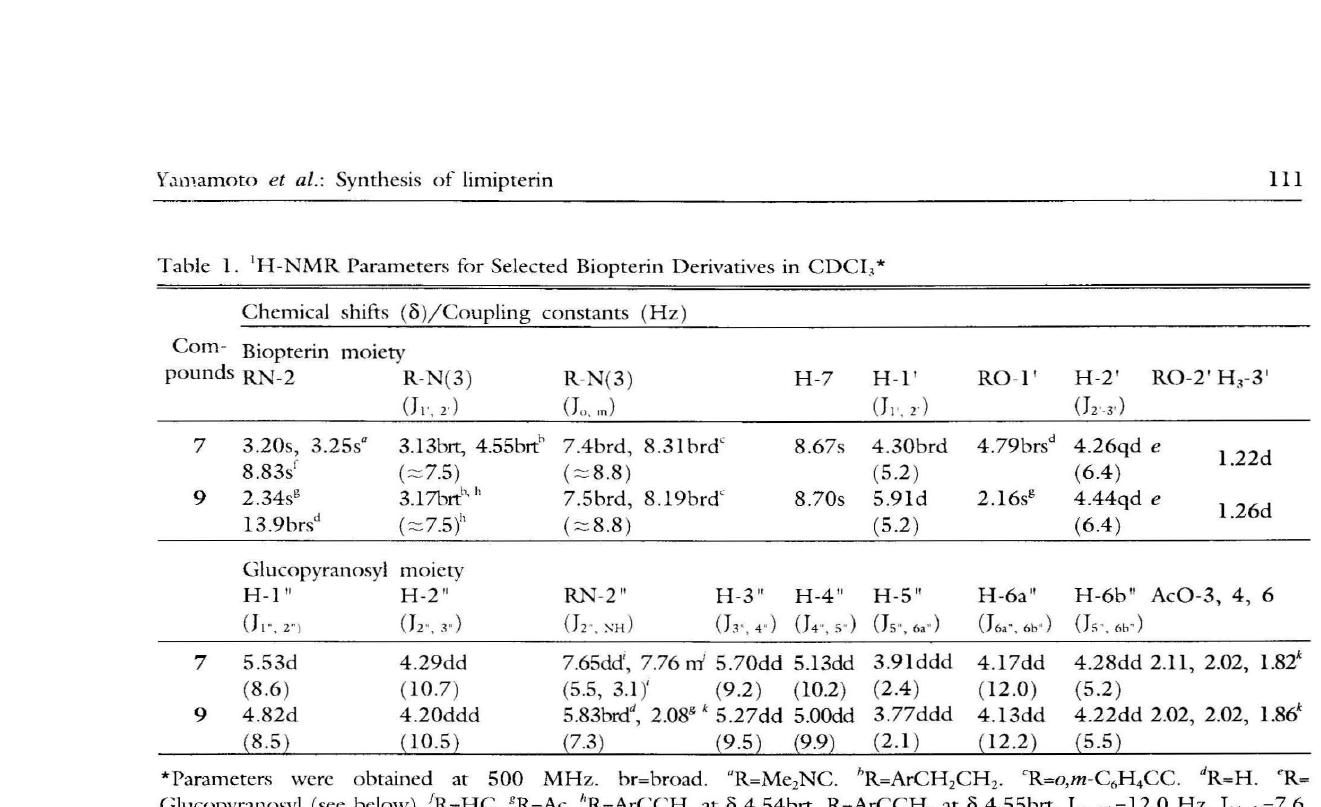
Table 1. IH-NMR Parameters for Selected Biopterin Derivatives in CDC!, * Chemical shifts (8)/Coupling constants (Hz) Com- Biopterin moiety pounds RN-2